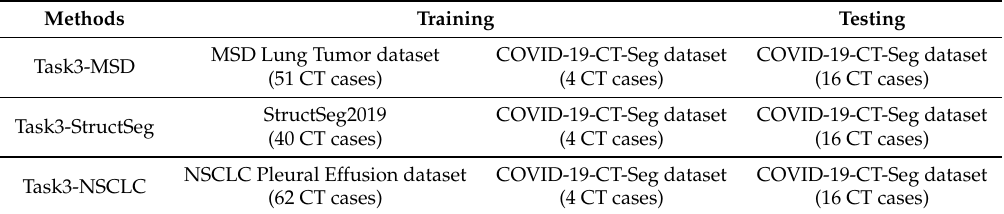
Table 4. Experiment settings of learning deep models with both COVID-19 and non-COVID-19 CT scans for automated infection